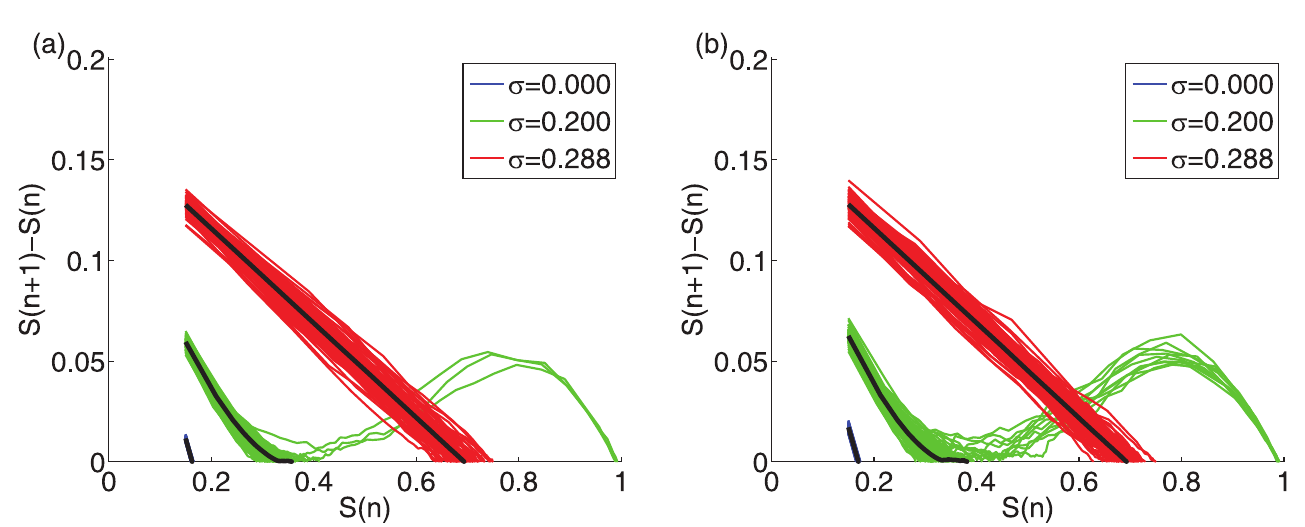
Fig 7. Phase-space diagrams for a constant initiator fraction p = 0.15. and various standard deviations σ = 0 (blue), σ = 0.2 (green), σ = 0.288 (red) for (a) ER graphs and (b) SF networks with γ = 3, with z = 10 and N = 10 4 . The colored lines refer to a hundred independent repetitions, while the black lines are their